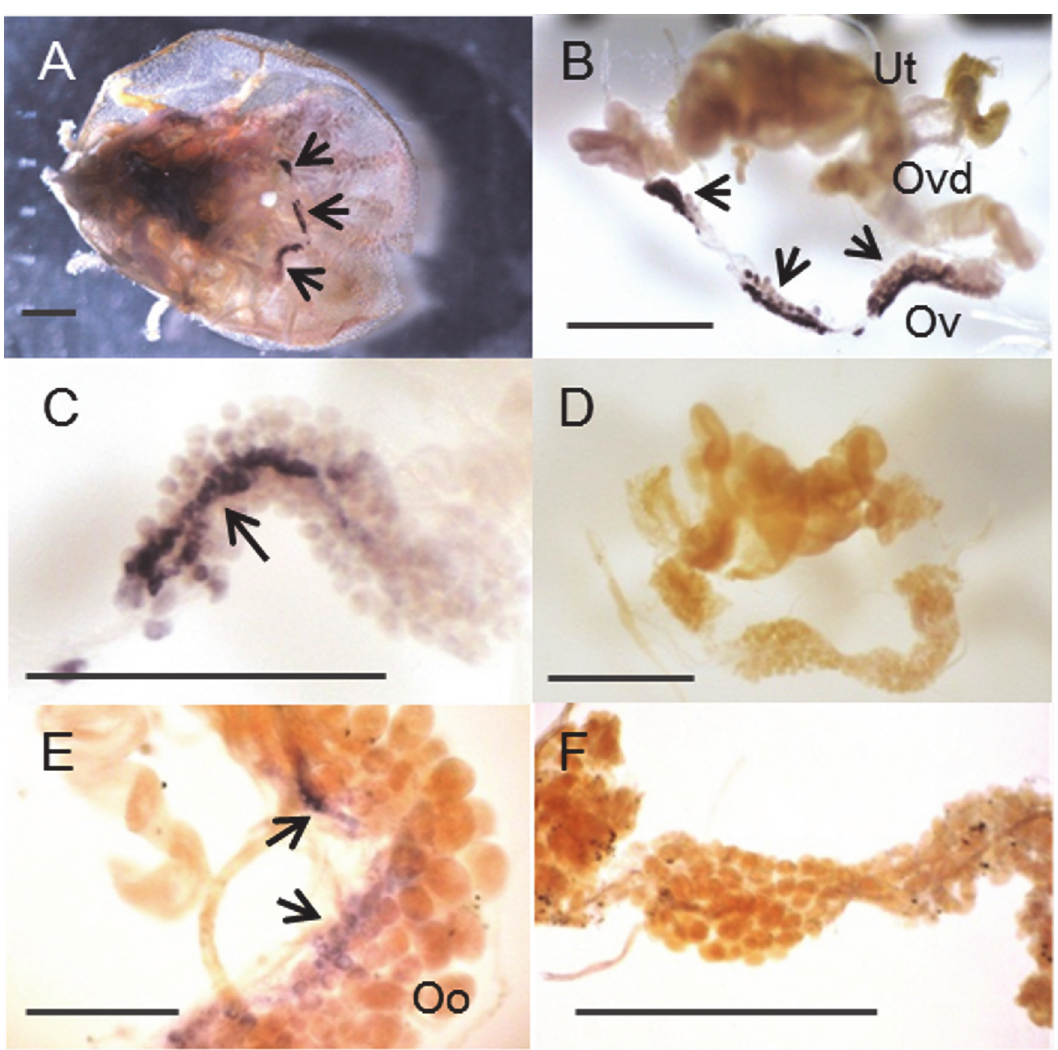
Fig 6. OmSpo expression in specific cells of ovaries from nymphs and adult females determined by WISH. An overall ventral view of tick tissues in a final instar nymph (A). OmSpo localization in dissected reproductive tissues from the nymph in Fig 6A (B). OmSpo localization in small cells of the ovary with a band-like configuration (C, magnification of Fig 6B). Ovary of a final instar nymph stained with the sense probe (D). OmSpo localization in the ovary of a mated female (E). Ovary of mated female stained with the sense probe (F). Arrows indicate staining of OmSpo with the antisense probe. Ticks have a single ovary (Ov) connected to oviducts (Ovd) from both sides. Oviducts open into a uterus (Ut). Developing oocytes (Oo) are attached outside the ovary. Scale bars indicate 1